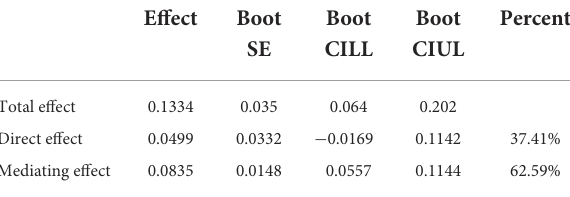
TABLE 5 Total, direct, and indirect